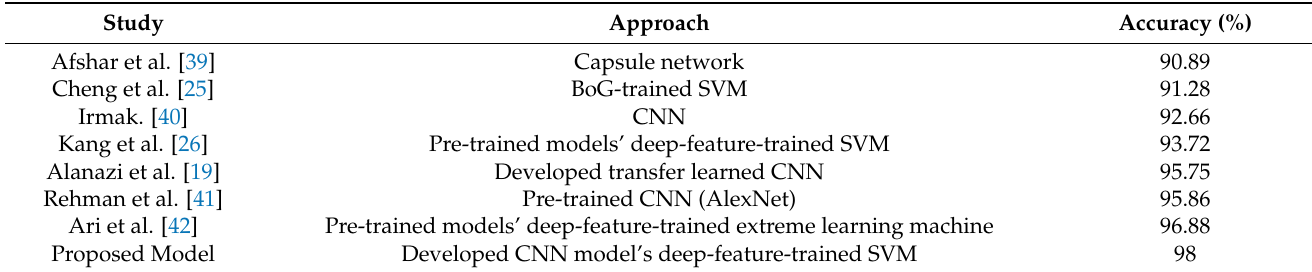
Table 3. Performance comparison of the proposed model with